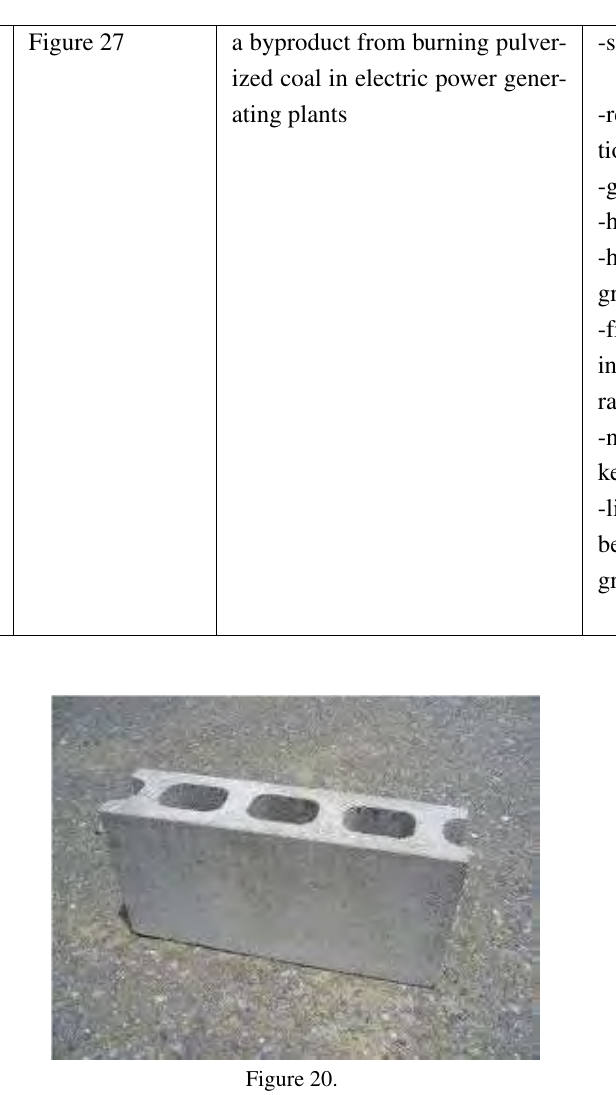
Figure 27 a byproduct from burning pulver- ized coal in electric power gener- ating plants